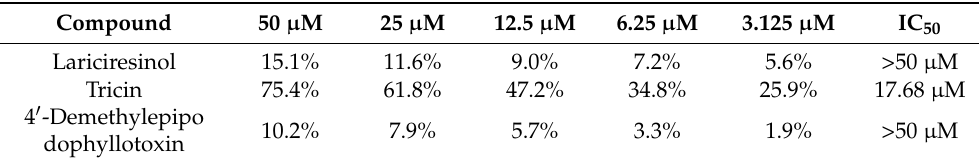
Table 4. The inhibition rates of candidate compounds against JNK1 at the first five concentra- tion